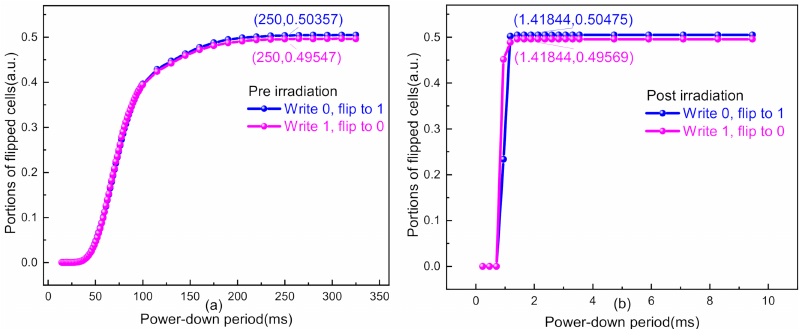
Figure 6. Portions of flipped cells at di ff erent power-down periods ( a ) before irradiation and ( b ) under 2 Mrad(SiO 2